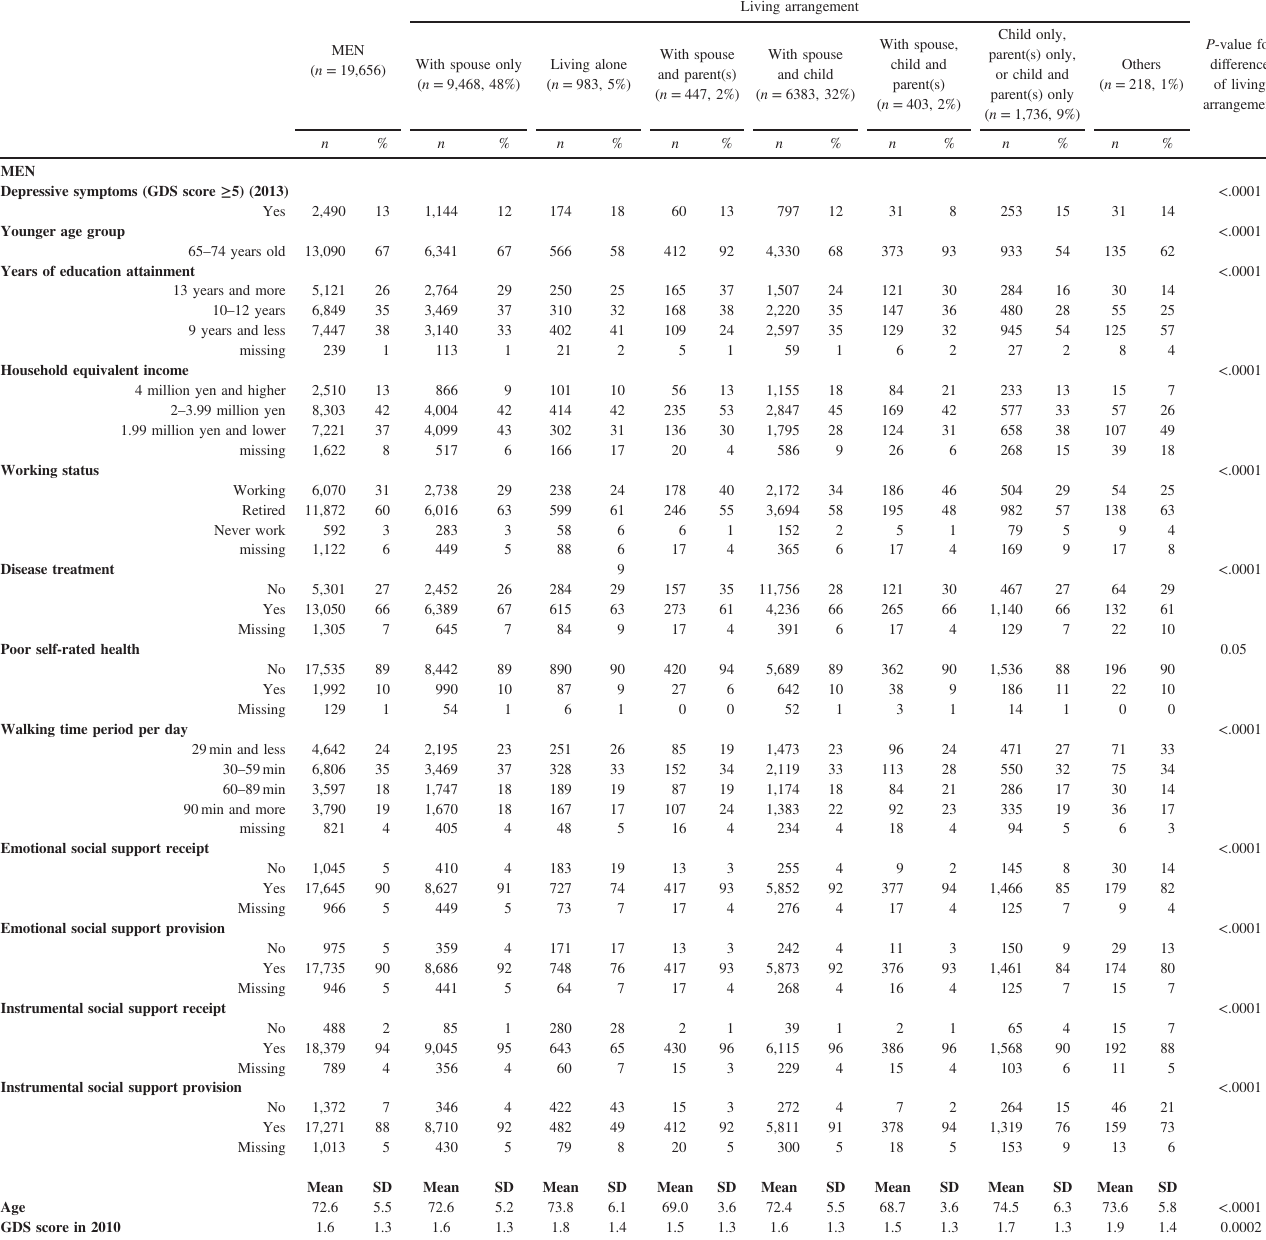
Living arrangement